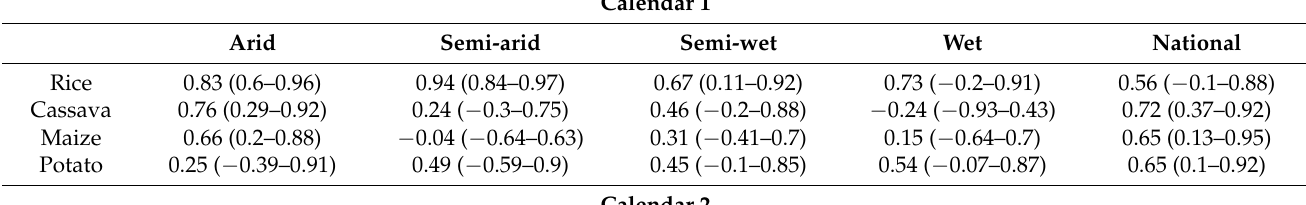
(cid:48) and P (cid:48) for each crop across four climate-zones and nationally. (cid:48) (cid:48) C1 and SM C2 ) and based on NDVI, (cid:48) (cid:48) C3 ) and an optimal length (SM C4 ). The optimal lengths are